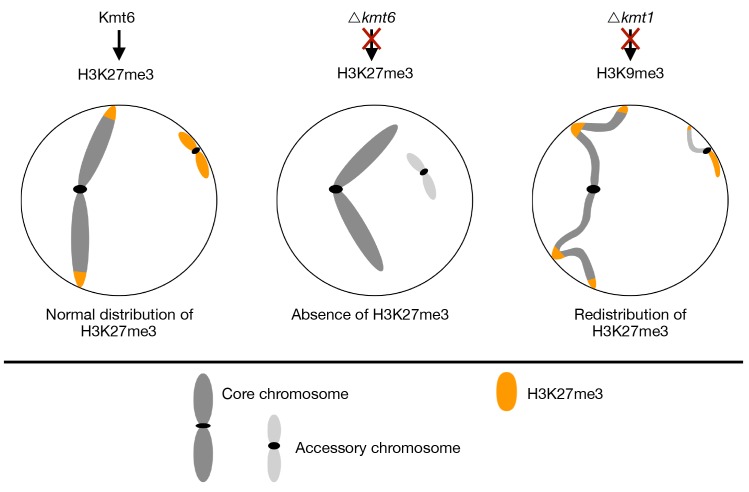
Working model to illustrate how H3K27me3 may influence nuclear localization of whole chromosomes or landmark genomic regions.In wildtype cells (left panel), H3K27me3 is localized in subtelomeric regions and on accessory chromosomes, directing those regions to the nuclear periphery and resulting in increased instability of these regions. Loss of H3K27me3 (middle panel) results in a relocation of former H3K27me3-enriched sequences to the inner nucleus and an increase of genome stability. Loss of the histone modification H3K9me3 enables H3K27me3 to spread, leading to mislocalization of H3K27me3, altered physical localization and chromatin interactions in the nucleus that fuel genome instability of these regions (right panel).